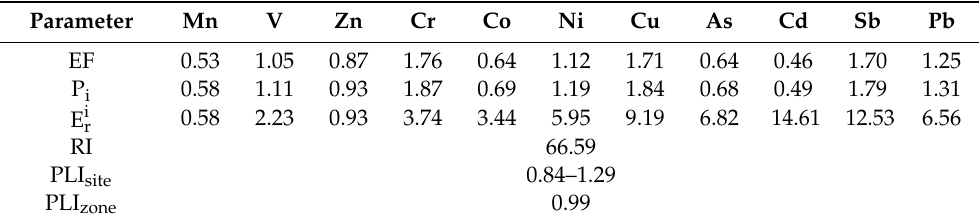
Table 4. The results of di ff erent evaluation methods for 11 PHTEs from 20 soil samples.